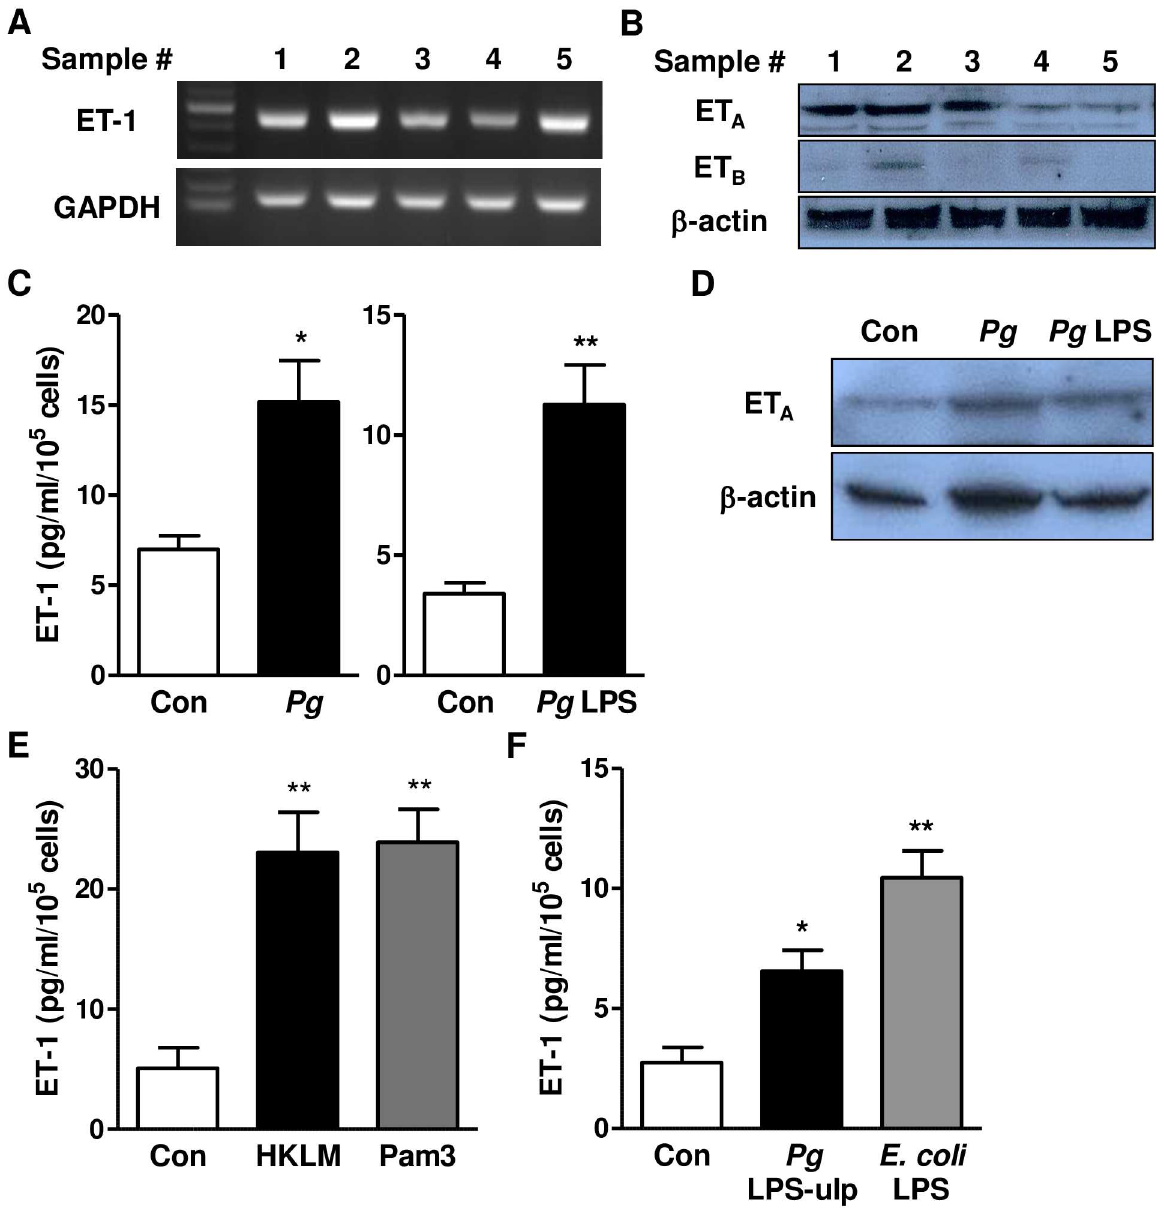
Fig 1. Endothelin expression in human gingival epithelial cells (HGECs) following P . gingivalis infection. (A and B) Expression of ET-1 mRNA (A), and ET A and ET B protein (B) in HGECs was analyzedby RT-PCR and western blot, respectively.(C and D) Inductionof ET-1 peptideand ET A protein by P . gingivalis and P . gingivalis LPS. After 18h infection with P . gingivalis (100 MOI) and 24h treatment with P . gingivalis LPS (1 μ g/ml), ET-1 peptideand ET A protein levels were analyzedby ELISA and western blot, respectively. ET-1 levels were measuredin culture supernatants from five samples (sample#1–5). A representative blot from sample #1 is shown. * P < 0.05; ** P < 0.01.(E and F) Involvementof TLR in ET-1 production. After 24h treatment with HKLM (10 8 cells/ml), or Pam3 (50 ng/ml) (E), or Pg LPS-ulp(1 μ g/ml) or E . coli LPS (50 ng/ml) (F), ET-1 productionwas evaluatedby ELISA in culture supernatants from five samples (sample#1–5). * P < 0.05; ** P < 0.01.